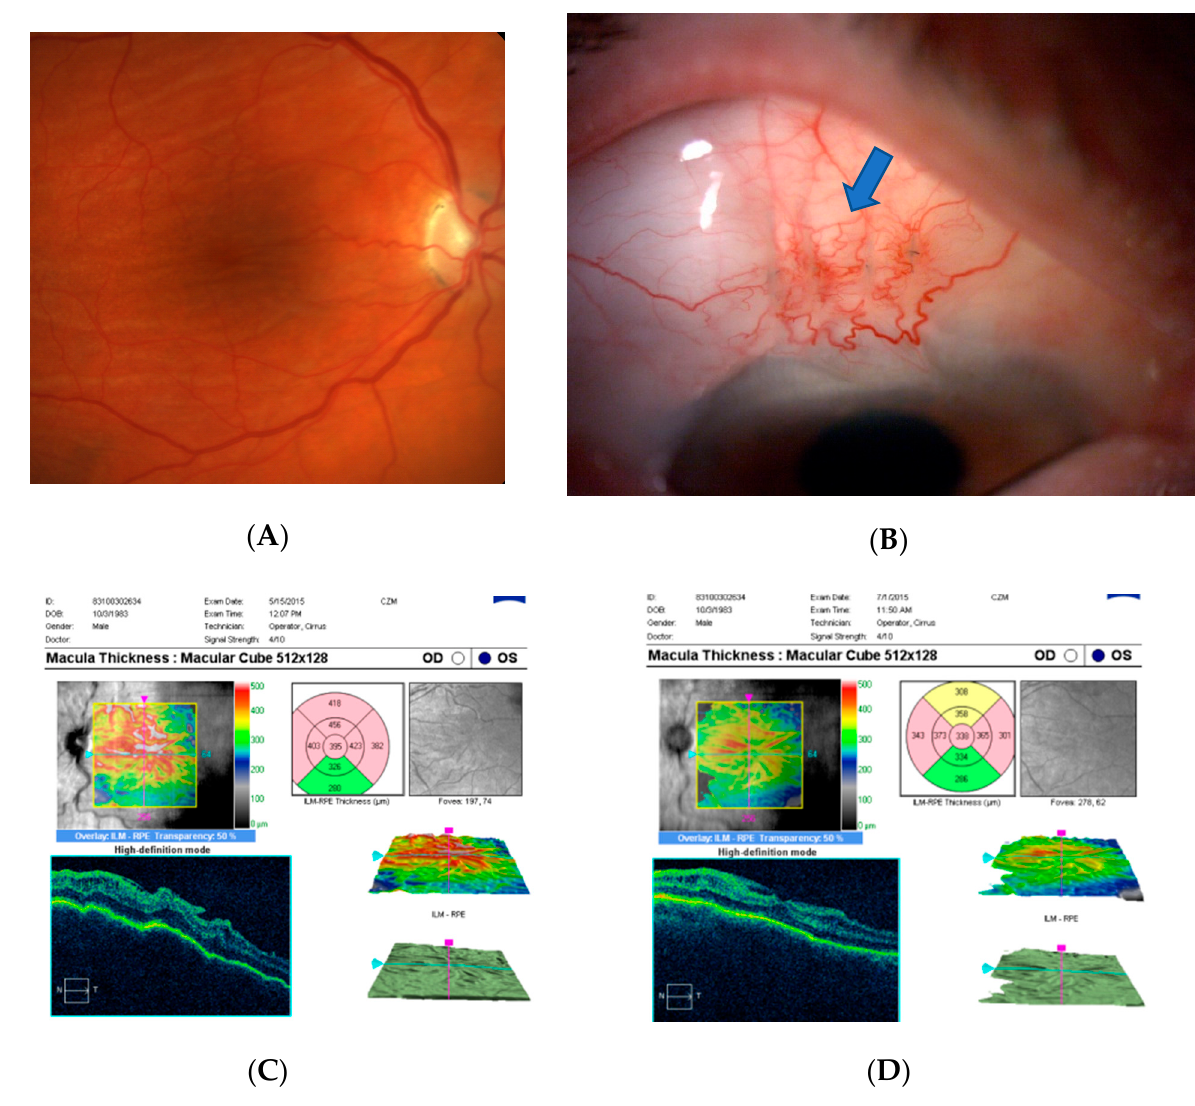
Figure 4. Sample case. ( A ) Eye fundus with hypotony maculopathy; ( B ) compressive sutures—1 day after the surgery (blue arrow points the sutures); ( C ) macular OCT before suturing; ( D ) macular OCT after suturing.